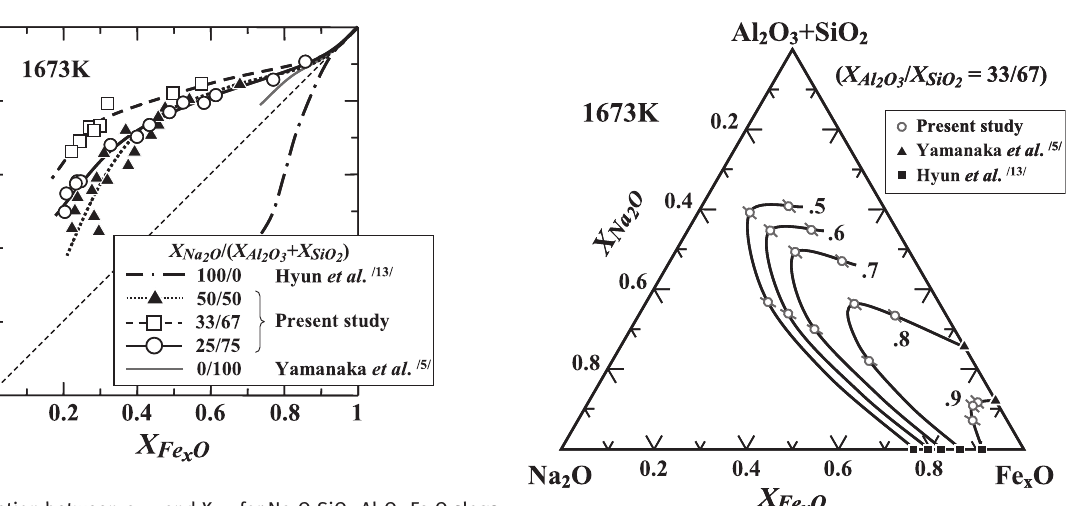
Fig. 5: Iso-activity curves for Fe x O in the pseudo-ternary system + SiO Na O-(Al O )-Fe O with an Al 2 2 3 2 x 1673